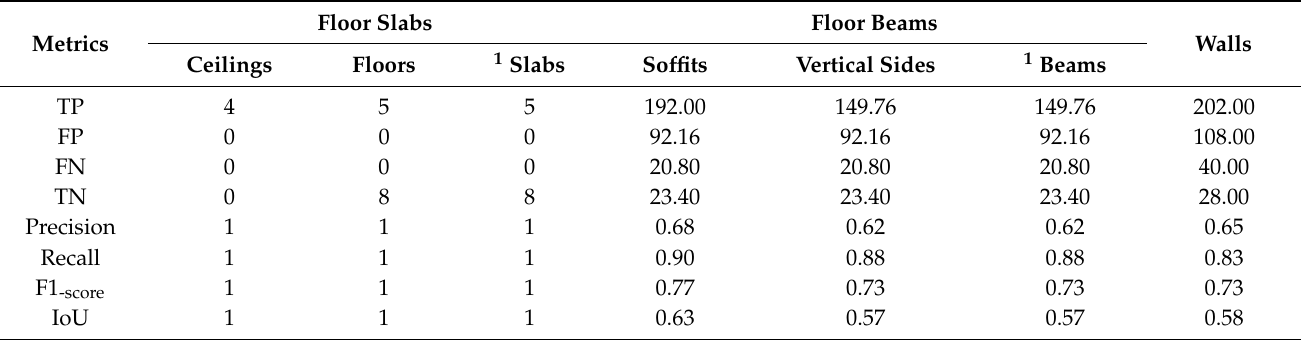
Table 2. Quantitative evaluation of the classification of points into class elements.